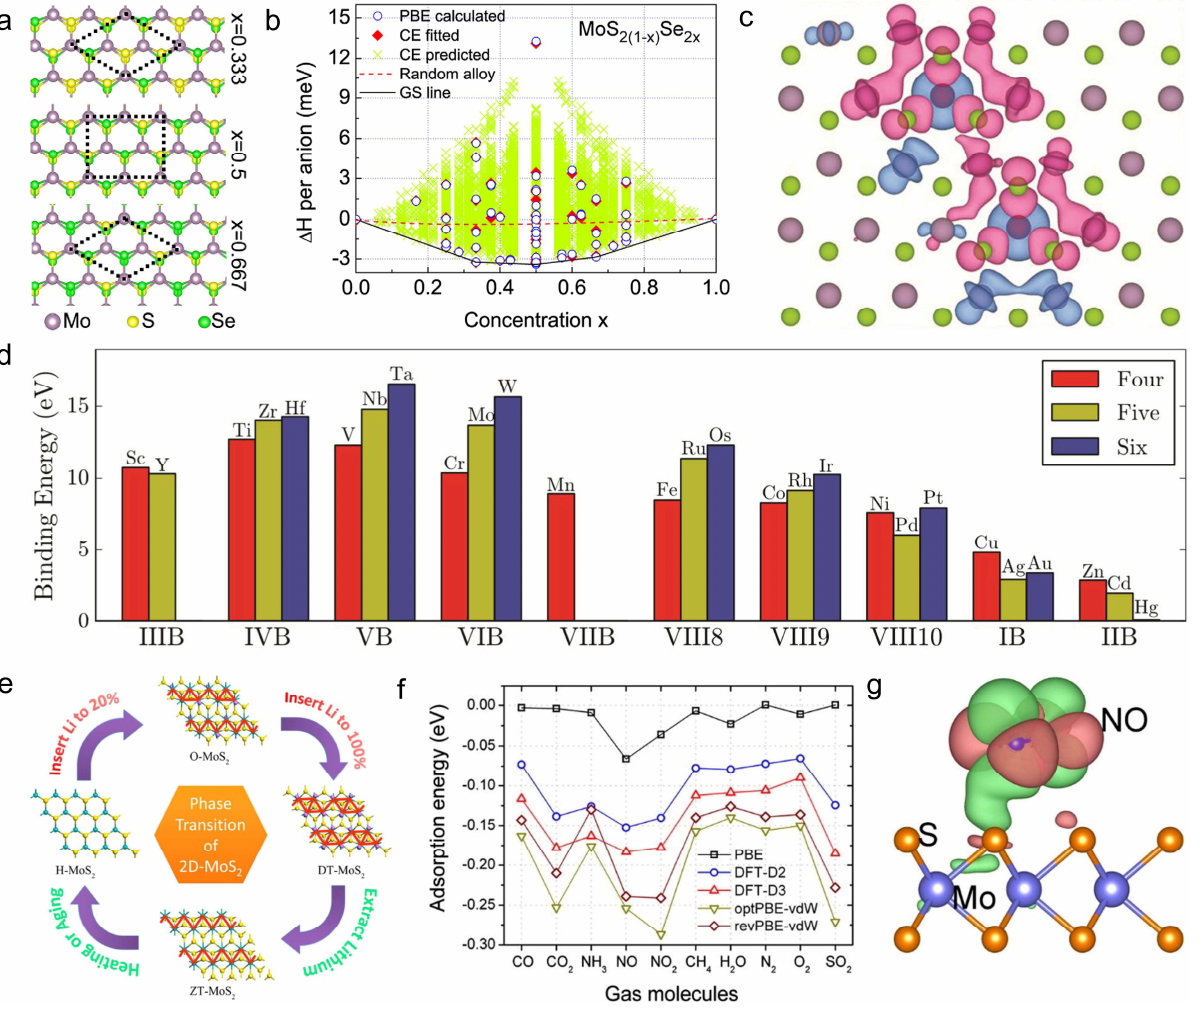
Figure 3. Theoretical calculations of 2D doped materials . ( a ) The ground state structure of MoS 2(1-x) Se 2x at 0 K. ( b ) First-principles calculated formation enthalpies for MoS 2(1-x) Se 2x, , along with the charge exchange fitted results. Reproduced with permission from [62]. ( c ) The isosurface plot shows the spin density when the Mn Mo - Mn Mo defects in MoSe 2 are separated by ∼ 6.5Å. Reproduced with permission from [63]. ( d ) First-principles calculated binding energies of monolayer MoS 2 with transition metal dopants from the periods four, five, and six. Reproduced with permission from [64]. ( e ) Four possible pathways for phase transition of MoS 2 monolayer structure by experimental and theoretical calculations. Reproduced with permission from [65]. ( f ) The adsorption energies of various gas molecules on MoS 2 monolayer determined from five methods. ( g ) Isosurface plot of the electron charge density difference for NO on MoS 2 monolayer. Reproduced with permission from [66].